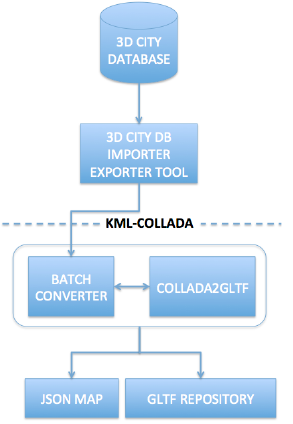
Figure 3 - 3D City model conversion pipeline